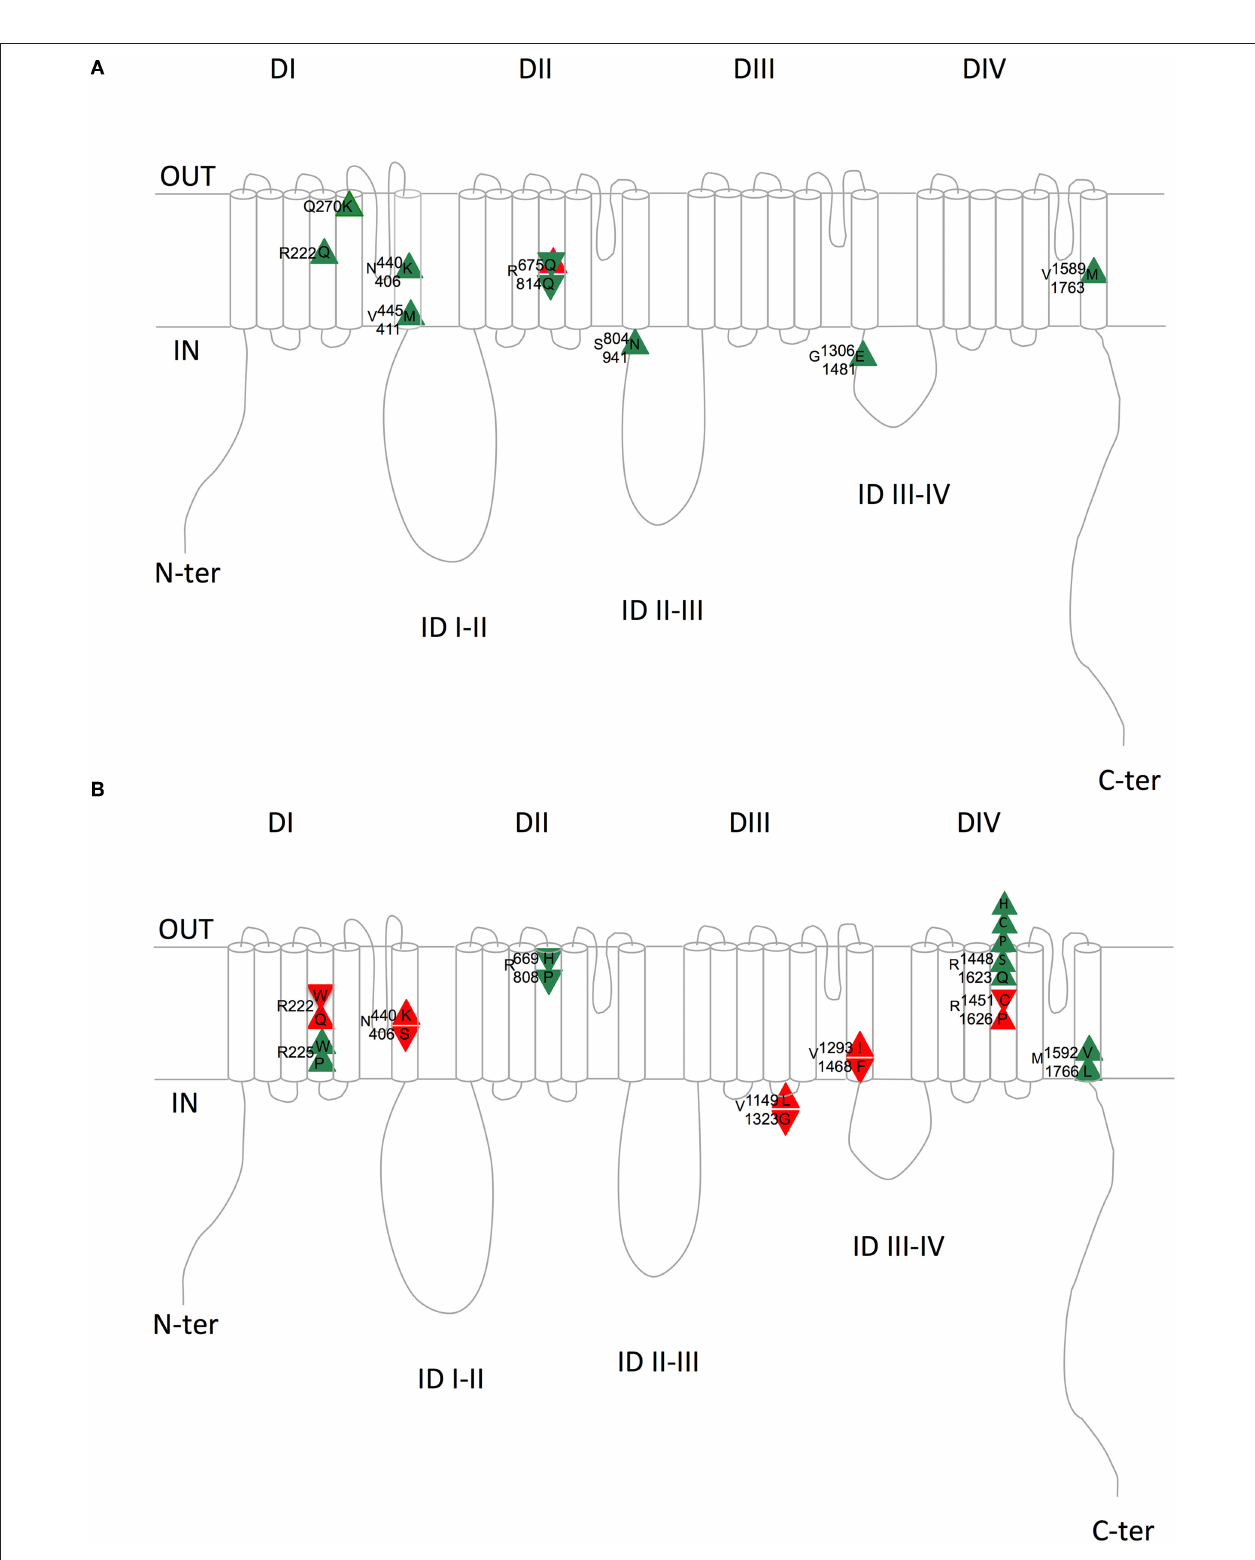
FIGURE 2 | Schematic representation of the equivalent Nav1.4/Nav1.5 amino acids with similar (A) or divergent (B) mutations in patients with skeletal (Nav1.4) or cardiac (Nav1.5) pathologies. Upward triangles indicate a gain of function on membrane excitability and downward triangles a loss of function on membrane excitability. Green and red triangles indicate consistent and inconsistent effects on Nav1.4 and Nav1.5 regarding membrane excitability, respectively. Upper amino acid number/letter, Nav1.4; Lower amino acid number/letter, Nav1.5. DI to DIV, domains I to IV; ID, intracellular interdomains; N-ter and C-ter, N-and C-terminus